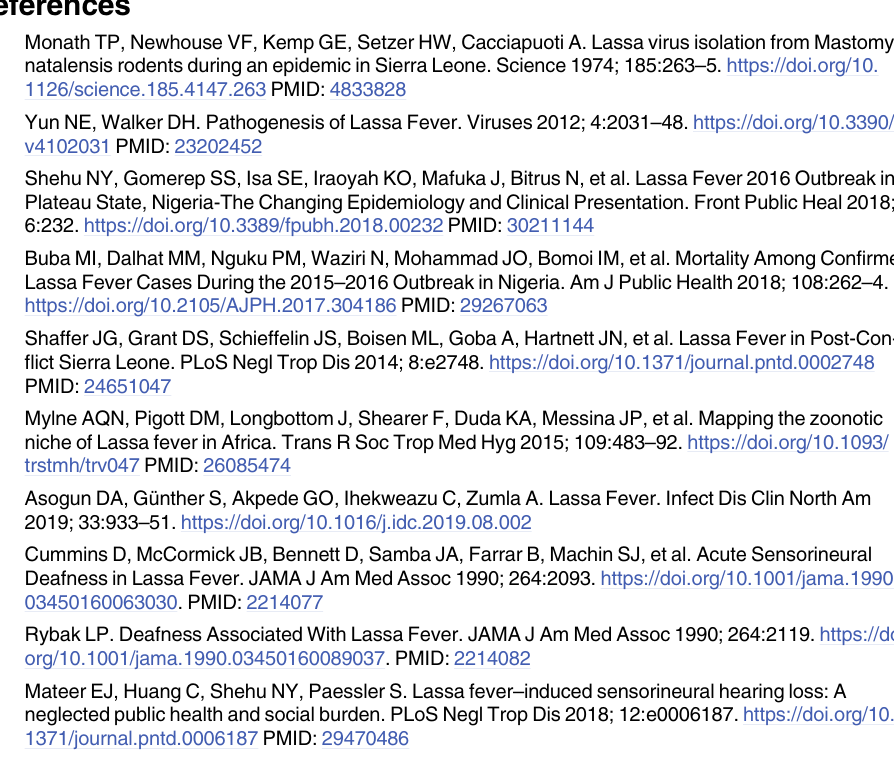
S6 Table. DPOAE results in T-cell depleted mice. S7 Table. Histopathological change in inner